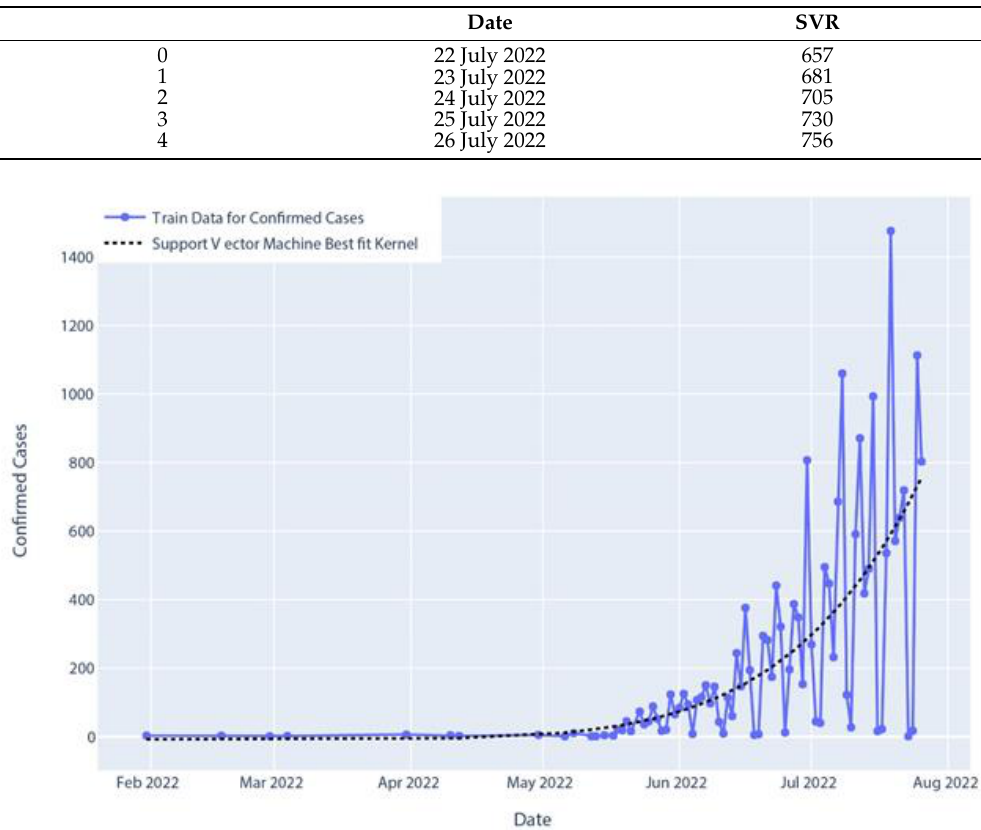
Table 2. SVR model confirmed case prediction for five days.